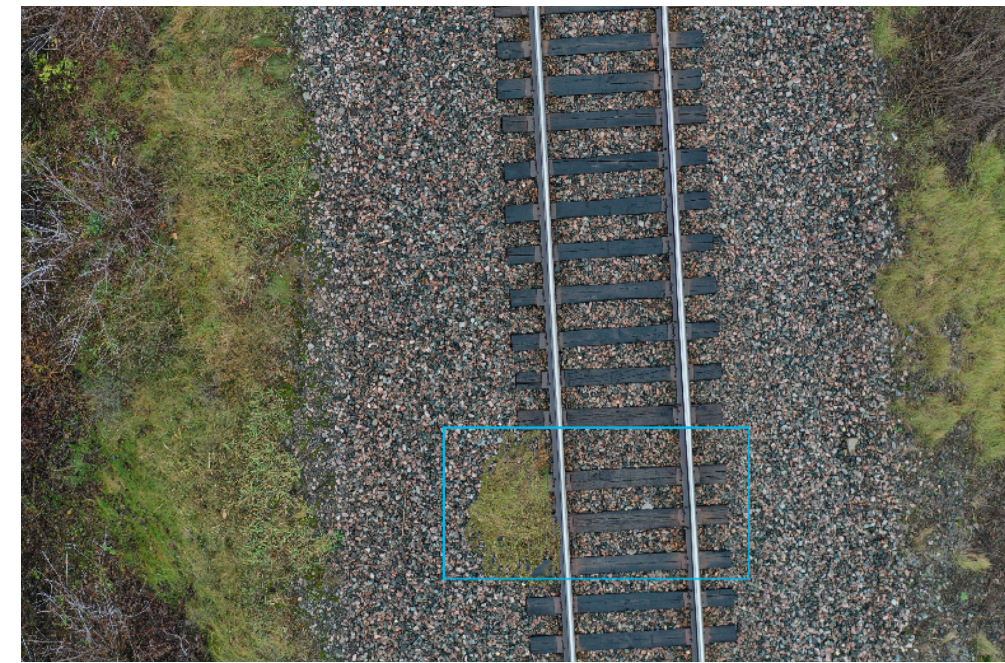
Figure 6. Example of